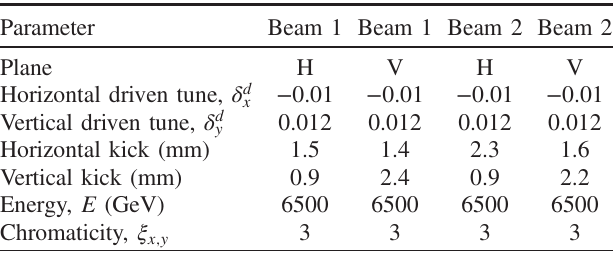
TABLE IV. ac-dipole and beam parameters for the measure- ments at the maximum operation energy of 6500 GeV. The horizontal and vertical kicks are calculated at a location with a β function of about 180 m.